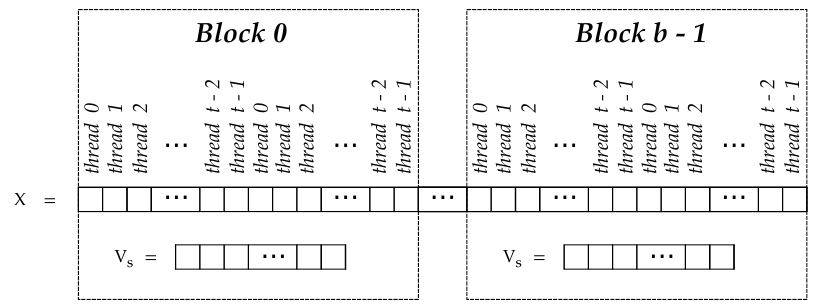
Figure 1. GPU threads running in